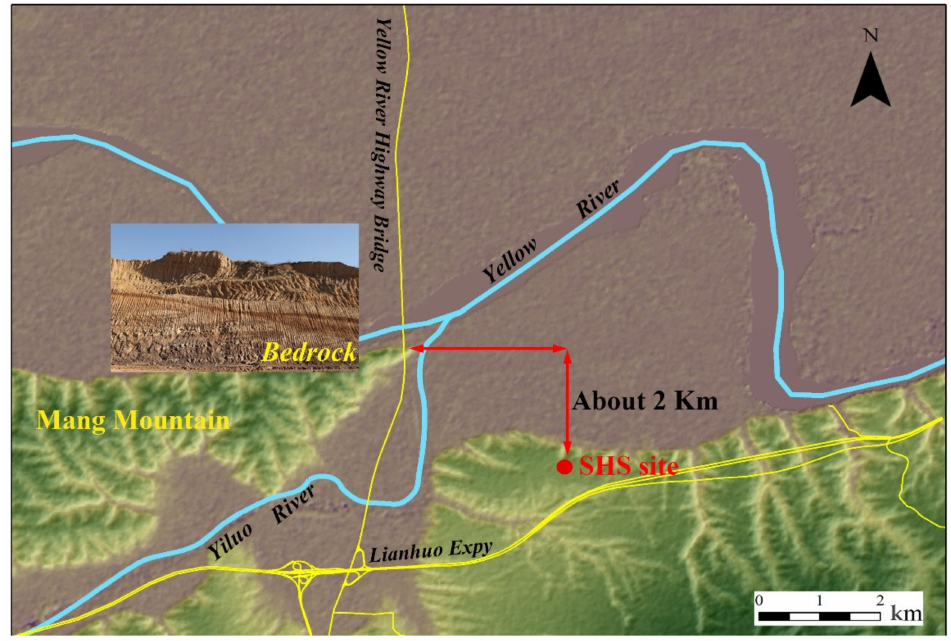
Figure 20. The locations of Mang Mountain and the SHS